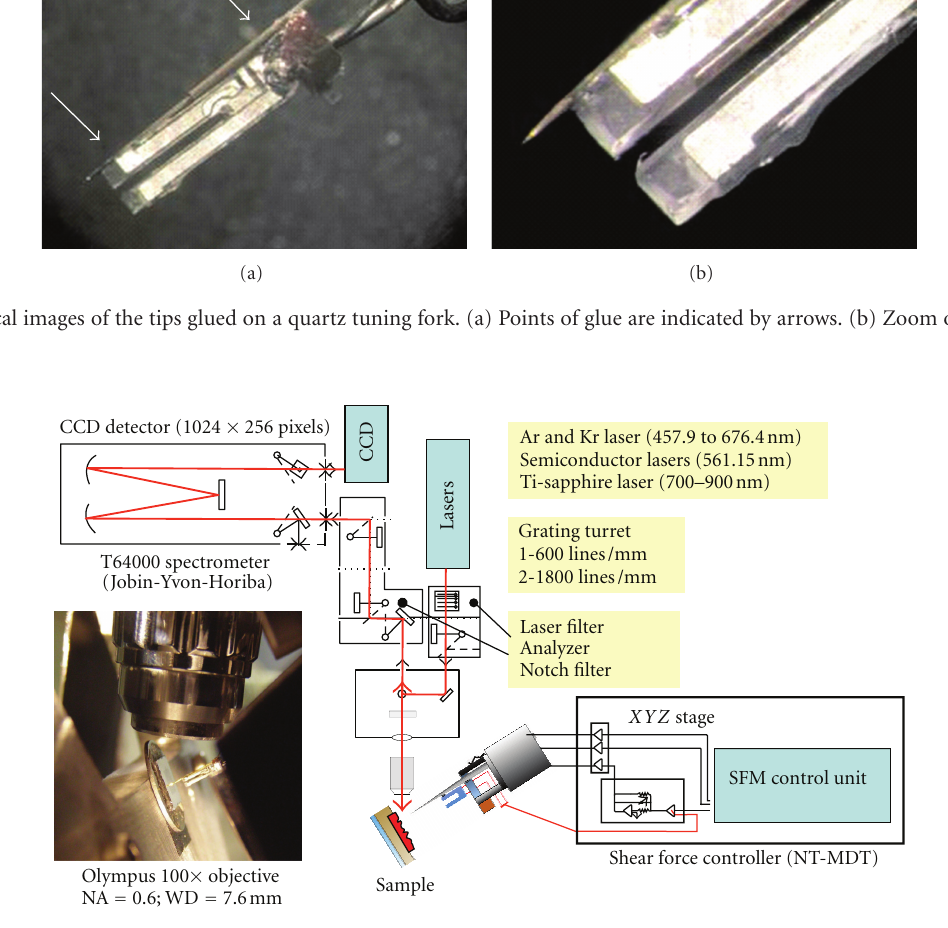
Figure 4: A schematic of the tip-enhanced Raman setup with an image of the tip-surface area (inset). The sharp gold tip is scanned through a strongly focused laser beam. The optical signal is detected by combining a spectrometer and a CCD detector. The axis of the illuminating/collecting optics is positioned at 55 ◦ with respect to the tip